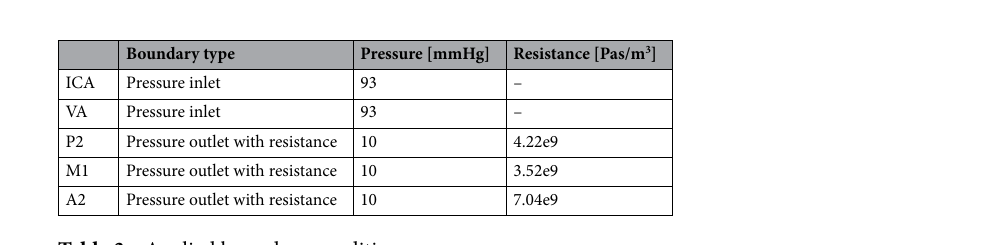
Table 3. Applied boundary